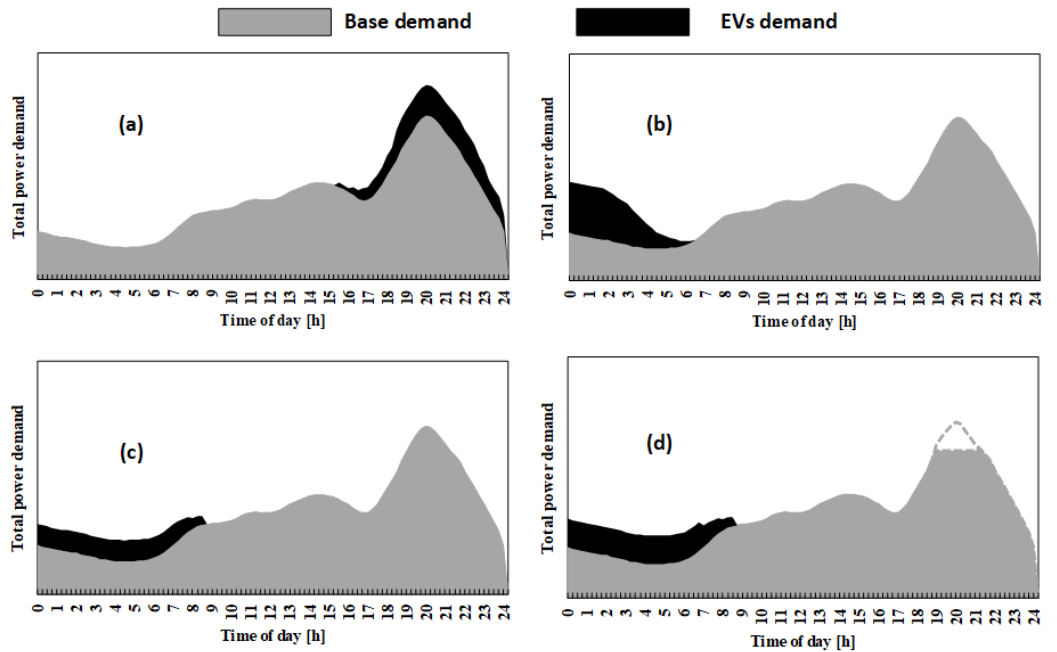
Figure 6. Total power demand profile with different charging and discharging methods. ( a ) Uncontrolled charging; ( b ) Delayed Charging; ( c ) Controlled Charging; and ( d ) V2G, V2B, and V2H.